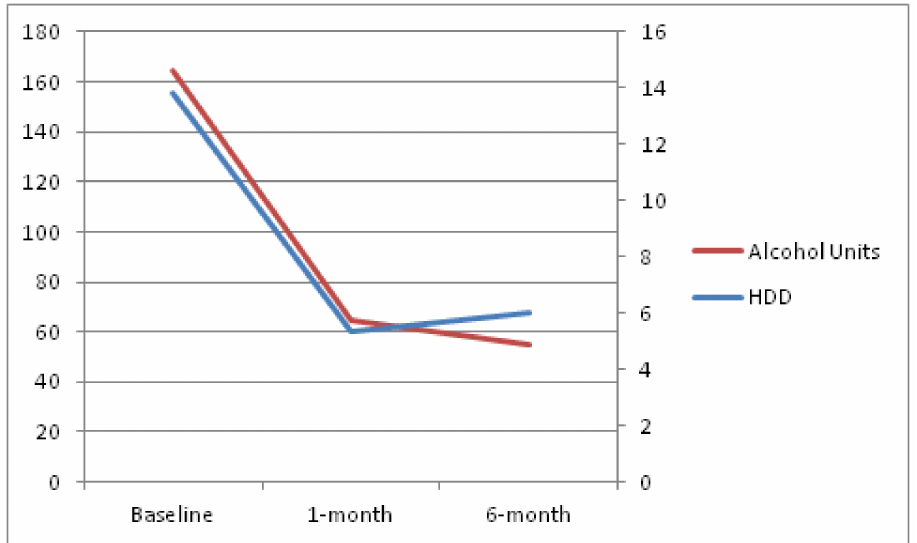
Figure 2. The change over time of study outcomes, according to per protocol analysis. The left axis shows alcohol units over the last 4 weeks. The right axis shows heavy-drinking days over the last 4 weeks. HDD: heavy drinking